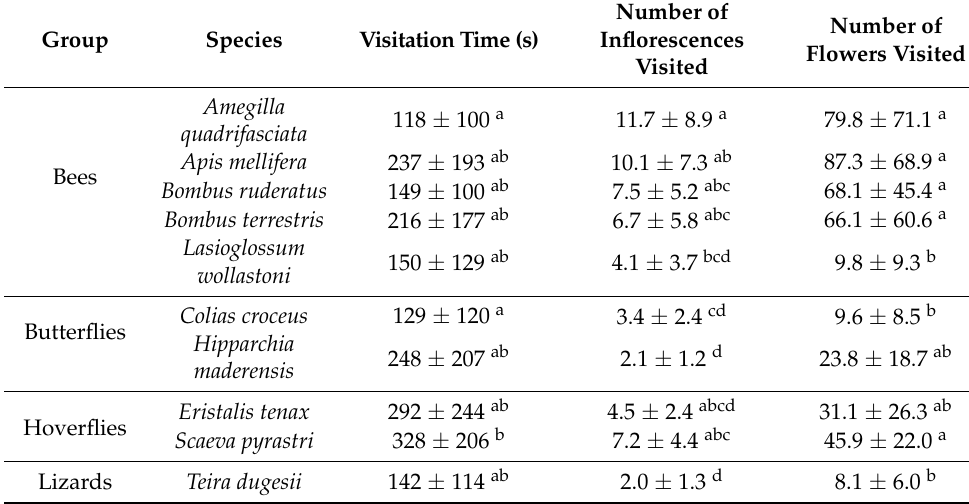
Table 2. Differences in components of foraging behavior between flower visitors of E. candicans . Twenty individuals/species were sampled except for L. wollastoni ( n = 18). Data are presented as mean ± SD. Letters designate groups of species that are statistically similar ( p < 0.05) to a particular behavior